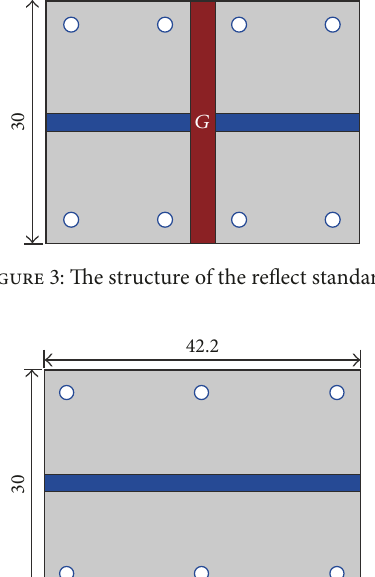
weight is to press down the SMD components for